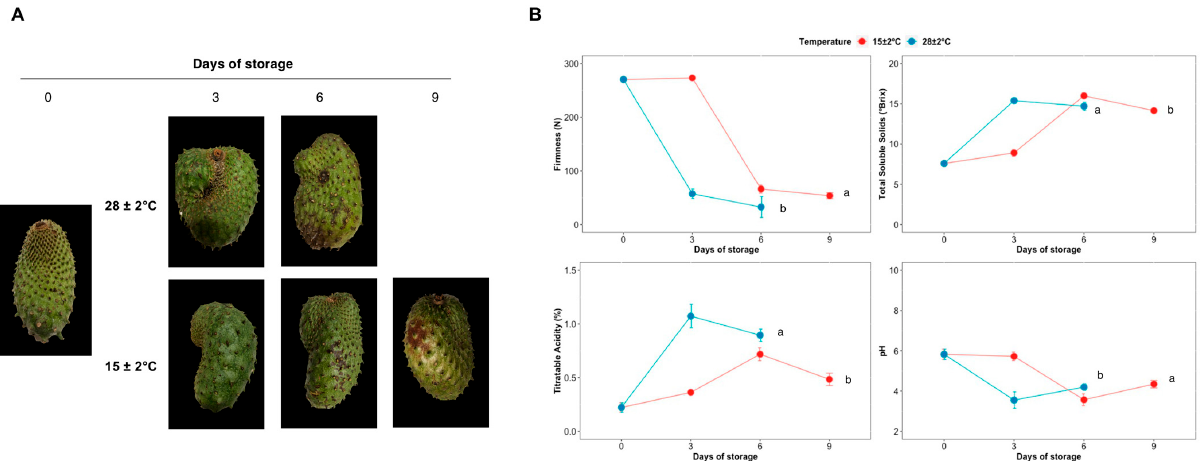
Figure 1. Experimental strategy and physicochemical analysis. ( A ) Soursop fruits stored at 28 ± 2 ◦ C and 15 ± 2 ◦ C (days of storage are the sample points after storage). ( B ) Firmness, Total soluble solids, Titratable acidity, and pH of soursop fruits. The points represent the mean of nine measurements and the vertical lines indicate the standard deviation of the means. Different letters indicate statistically significant differences at p < 0.05 between temperatures using the means of 27 and 36 data per the temperature stored at 28 ± 2 ◦ C and 15 ± 2 ◦ C,